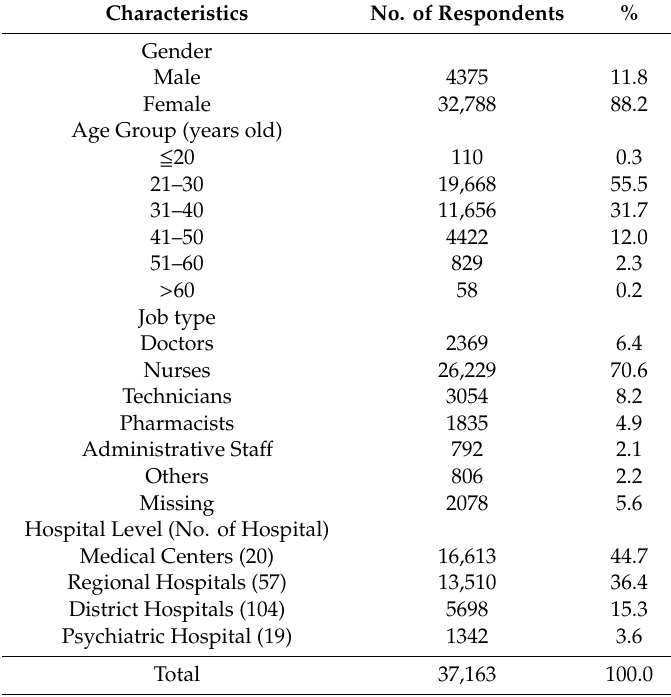
Table 1. Characteristics of respondents for a nationwide hospital patient safety culture survey in